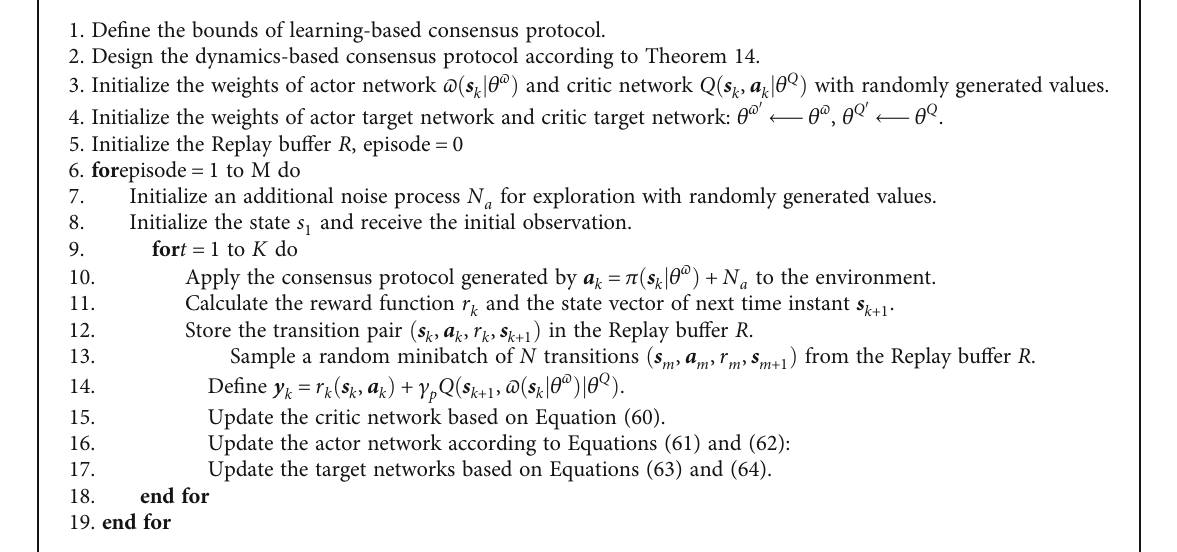
Algorithm 1: Online scheduling based on DDPG algorithm.